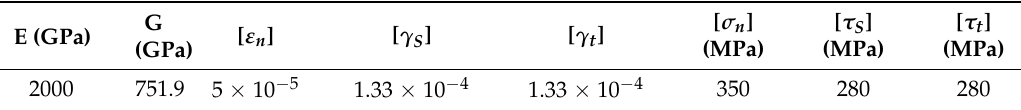
Table 2. Mechanical properties of the adhesive layer.